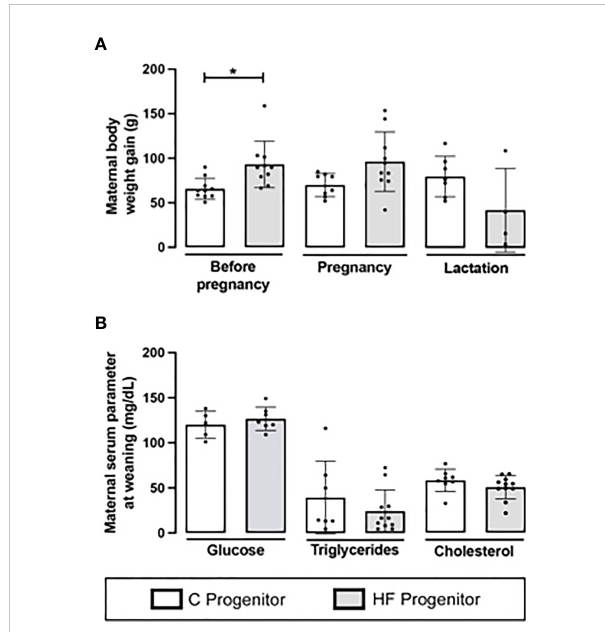
FIGURE 2 Effect of high-fat (HF) diet on the body weight and serum metabolites of rat female progenitors. (A) Maternal body weight gain for 8 weeks prior conception, and during pregnancy and lactation; and (B) Serum glucose, triglycerides, and cholesterol levels of control (C) and HF dams at weaning. Data are presented as mean ± standard deviation and statistically signi fi cant differences were determined by unpaired Student ’ s t test. * p < 0.05 .